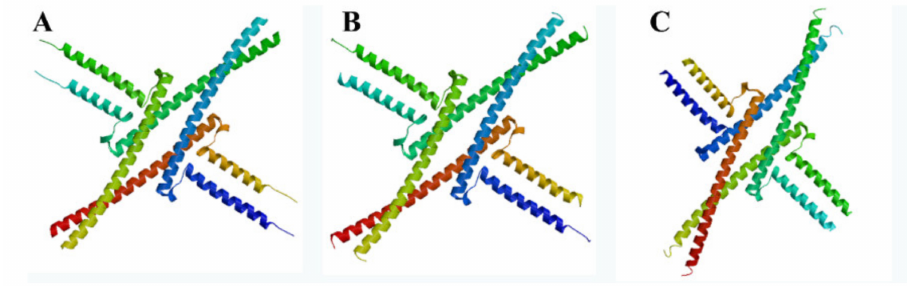
Figure 3. The 3D structural model of proteins. ( A ) NnSEP1; ( B ) NnAGL9; ( C )